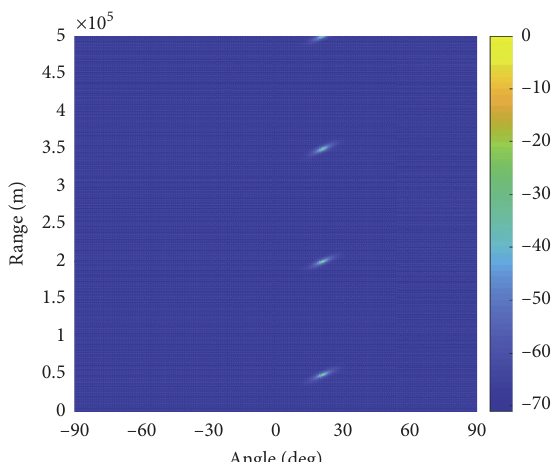
Figure 2: MUSIC spectrum with Δ f